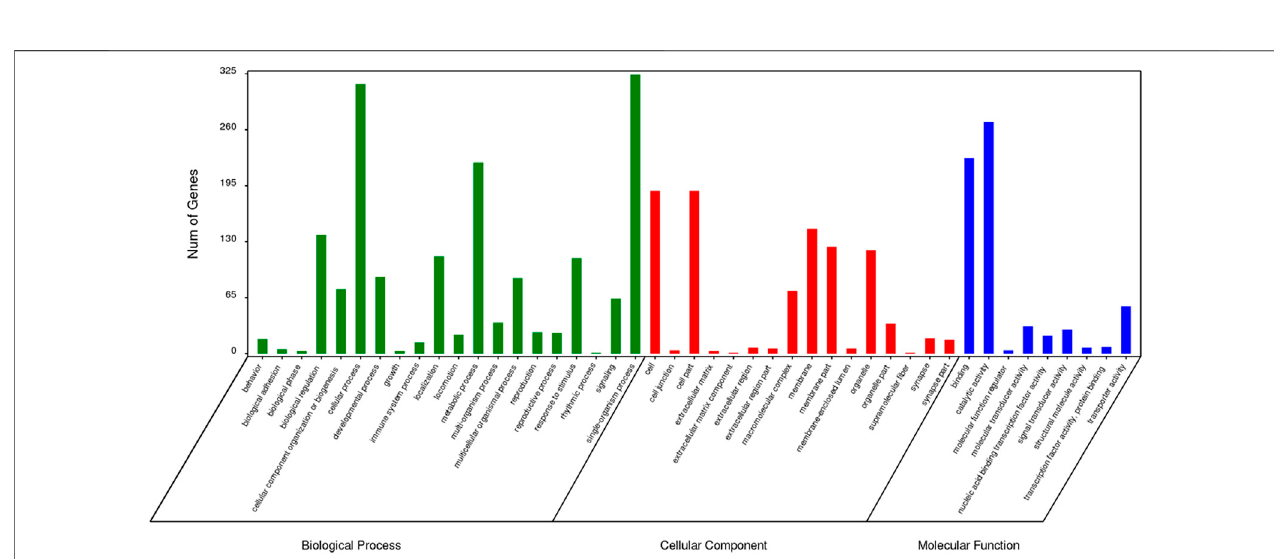
FIGURE 5 | GO function classi fi cation of speci fi c genes of Zeugodacus cucurbitae (Coquillett).